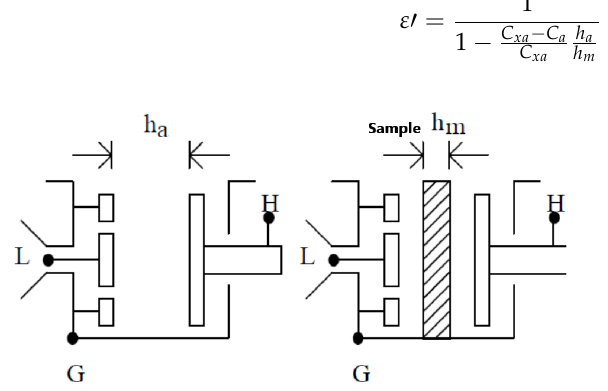
Figure 5. Diagram of the air-gap capacitance bridge technique. G stands for ground. L and H indicate the two electrodes.